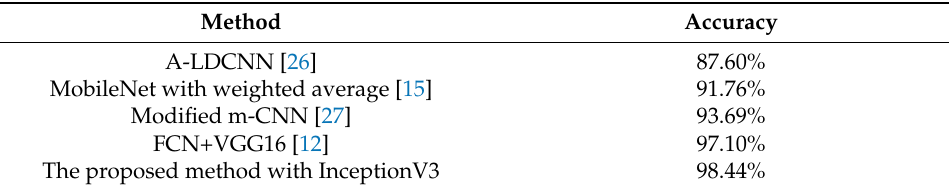
Table 9. Classification accuracy of different deep learning